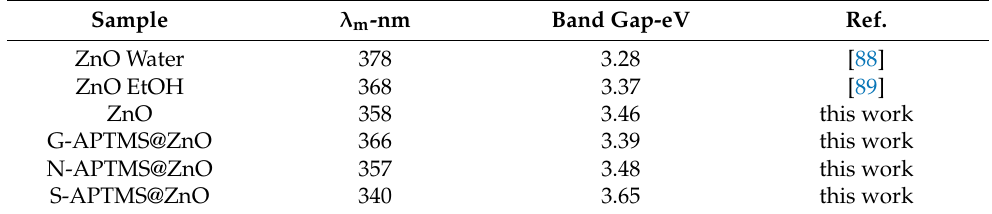
Table 5. Exitonic peaks and estimated band gaps of the synthesized samples and literature references.